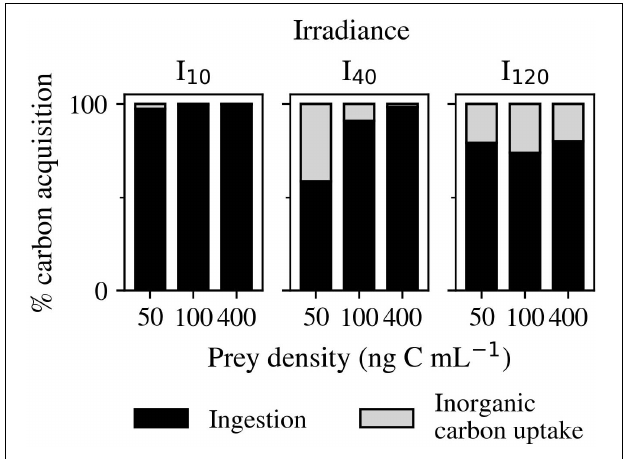
FIGURE 6 | Experiment 2: Percentage of carbon acquired from inorganic carbon uptake and ingestion over the three light (I 10 , I 40 , and I 120 ) and three prey density treatments (50, 100, and 400 ng C mL − 1